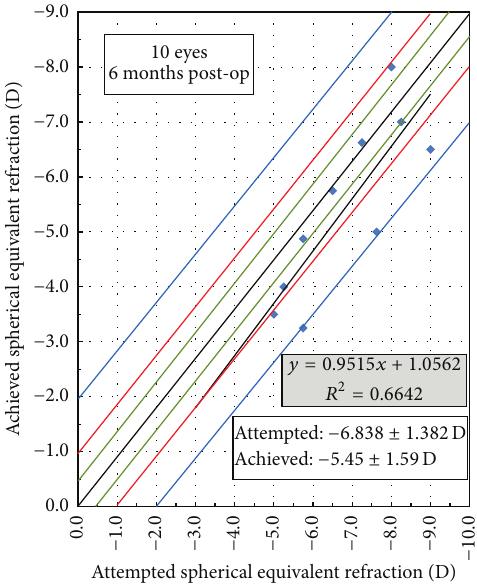
Figure 3: Attempted versus achieved spherical equivalent 6 m postoperatively.